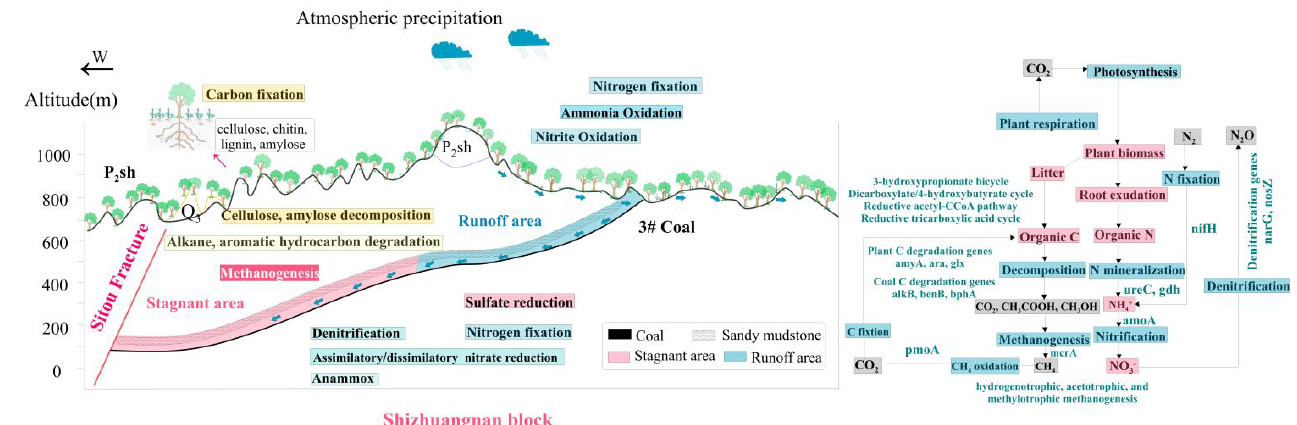
Figure 9. Microbial C-N-S cycle pattern in Shizhuangnan Block.